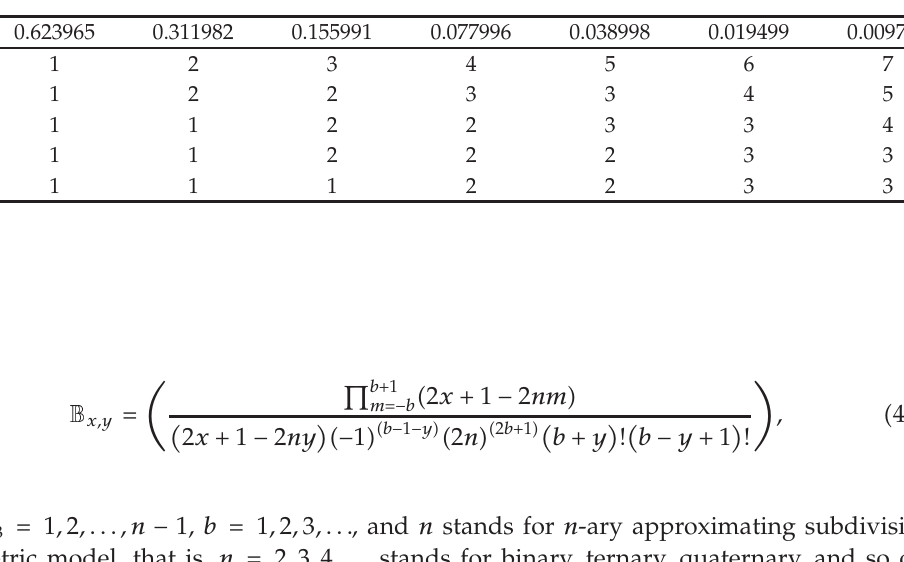
Table 4: Subdivision depth of tensor product n -ary approximating volumetric models: here n presents the arity of subdivision volumetric model and (cid:5) presents error